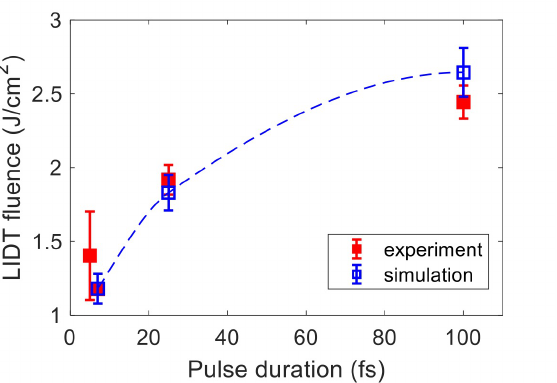
Figure 6. Laser damage fluence thresholds as function of laser pulse duration: simulation results compared to experimental data [27,47]. The dashed blue line through the simulation points is merely to guide the